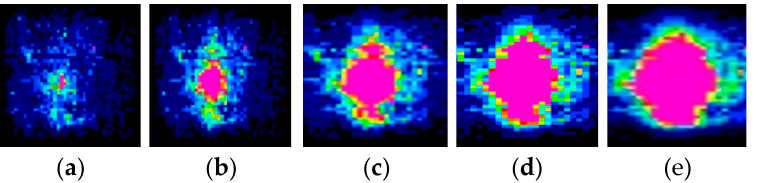
Figure 5. The distribution of contact stress distribution of thin plate with the change of load distribution: ( a ) load of 250 N; ( b ) load of 500 N; ( c ) load of 750 N; ( d ) load of 1000 N; and ( e ) load of 1250 N.